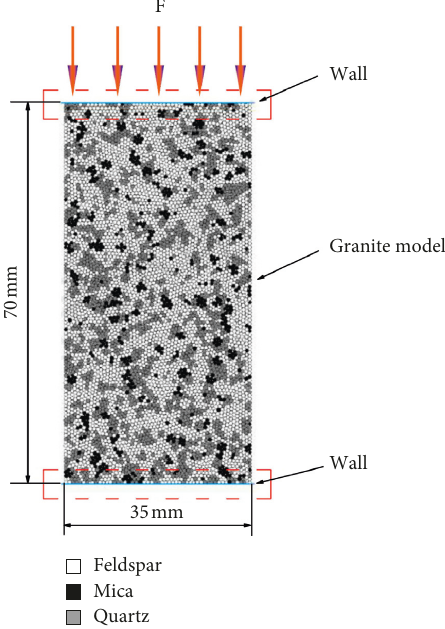
Figure 1: Rock model and boundary conditions. Table 1: Mesomechanical parameters of rock model.